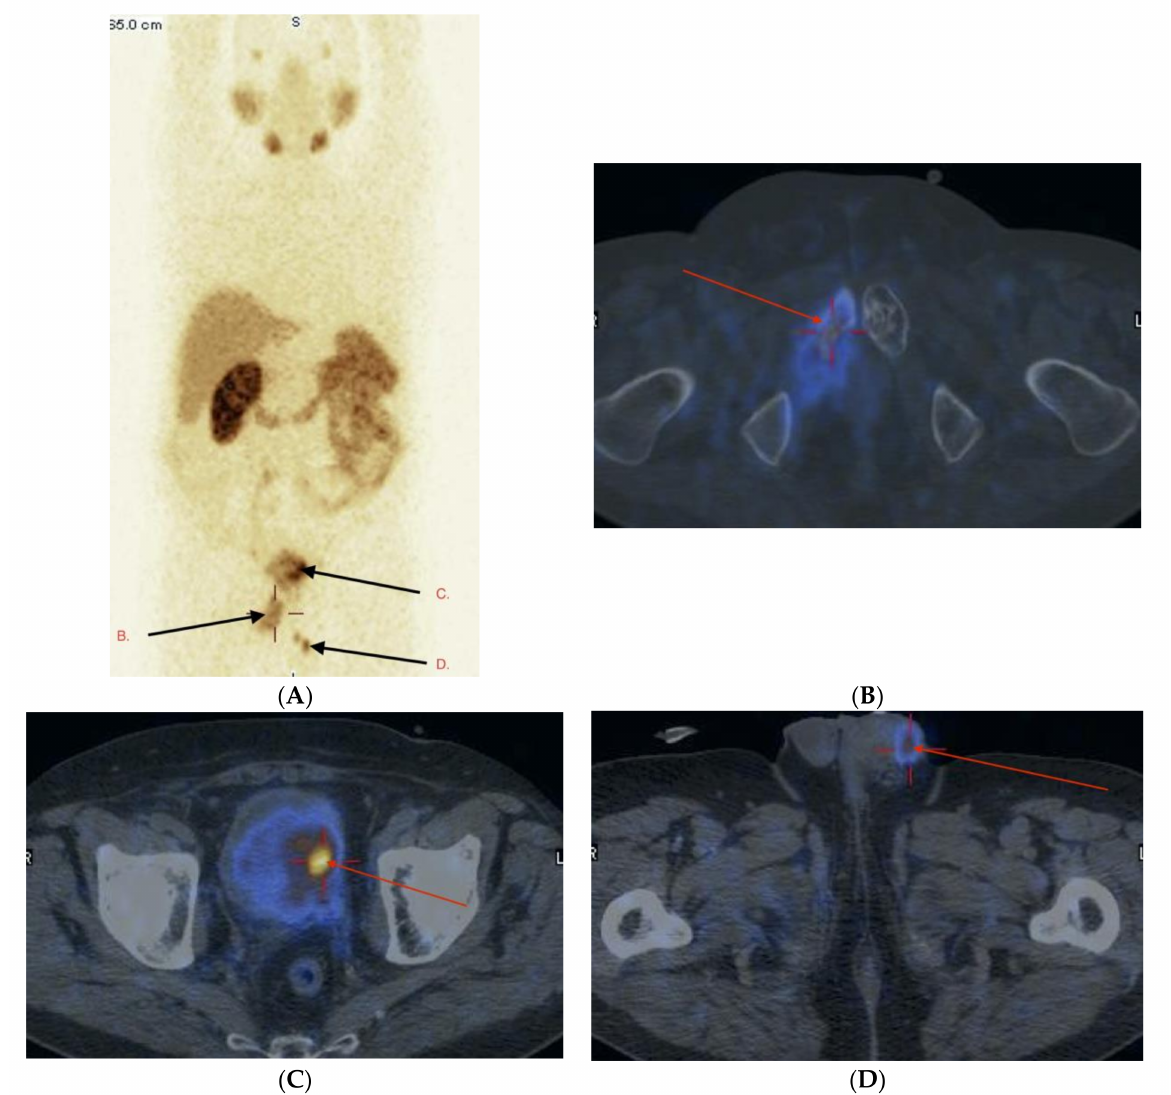
Figure 4. ( A – D ) Male 66 years, cTxN1M1, initially non-resectable, PCa, GlS = 7 (4 + 3). PSA 35.2 ng/mL. After pallia- tive radiotherapy on the left hip and pubic bones, during hormonal therapy, previous history of hematuria. Currently, on the basis of TURCUT biopsy a bladder tumor can be seen on the left wall, also distal urethra involvement. His- tology PCa GlS = 9 (4 + 5). Whole body WB-SPECT/CT (MIP) ( A ) and additional image fusion SPECT/CT ( B – D ) with [ 99m Tc]Tc-PSMA-T4. High pathological uptake of radiotracer seen in right pubic bone (arrow B), left bladder wall involve- ment (arrow C) and distal urethra involvement (arrow